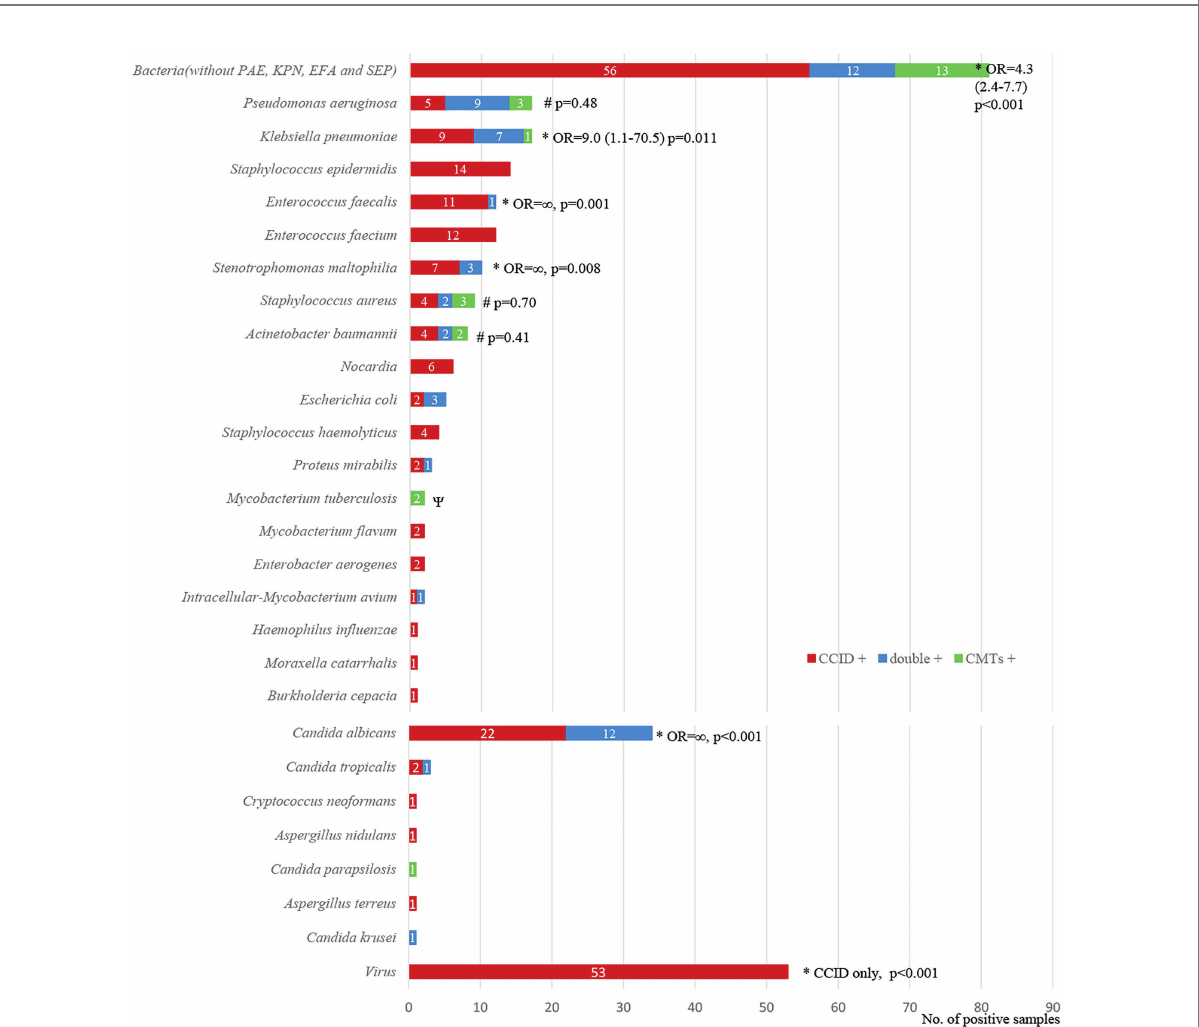
FIGURE 5 Diagnostic concordance between chips for complicated infection detection (CCID) and conventional microbiological tests (CMTs) for different pathogens. * , # The rates of positive results are significantly higher ( p < 0.05) or marginally higher ( p > 0.05) using CCID. OR, odds ratio.